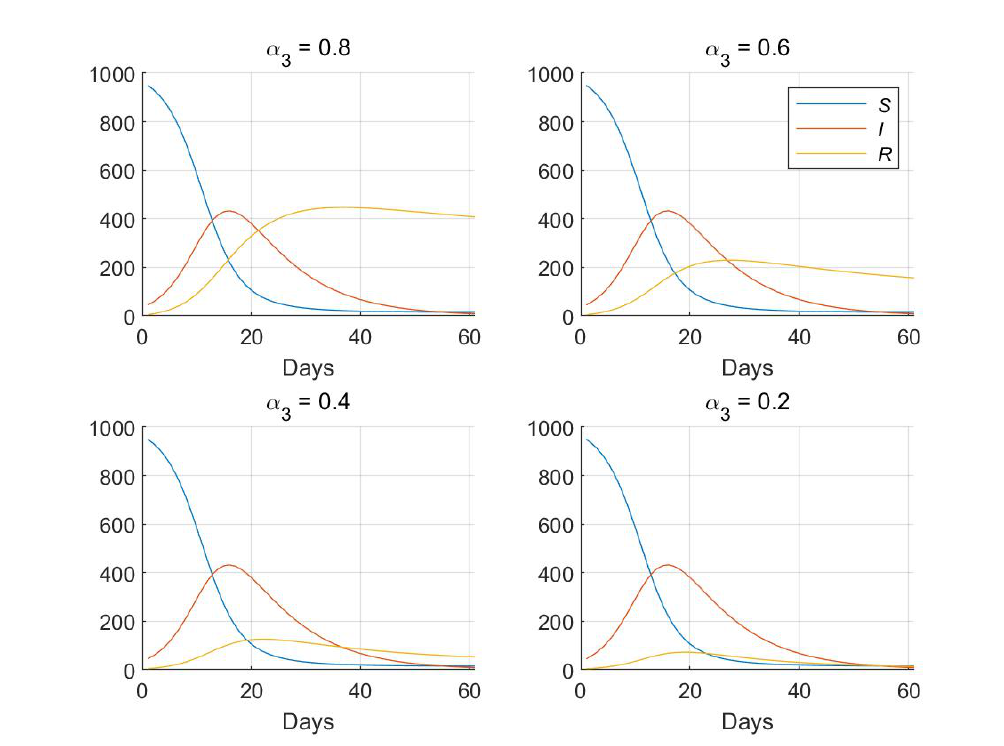
Figure 3. Simulation results for various α 3 and α 1 = α 2 =